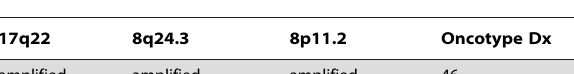
Table 2. FISH scores for ER + /HER2- breast cancer tissue samples.